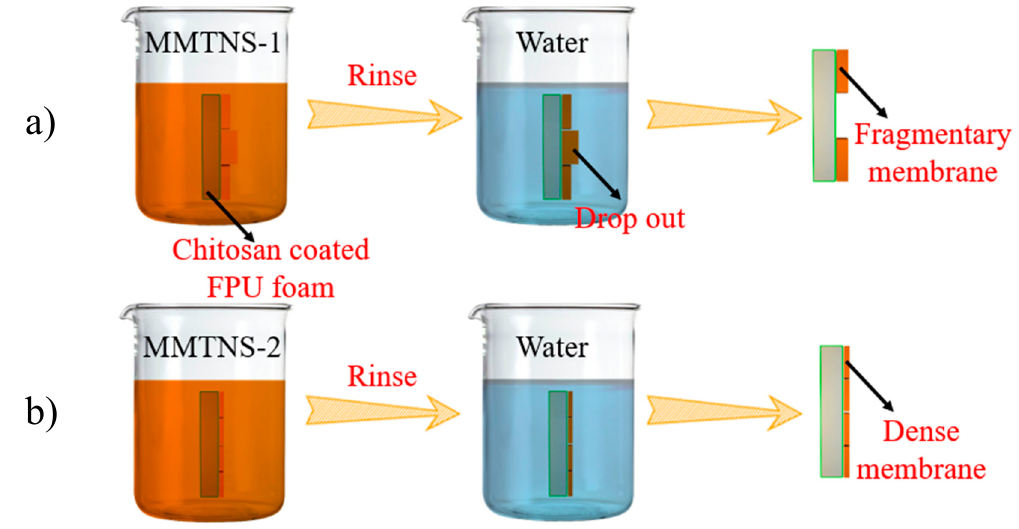
Figure 10. Schematic diagram of the deposition behavior of MMTNS-1 ( a ) and MMTNS-2 ( b ).